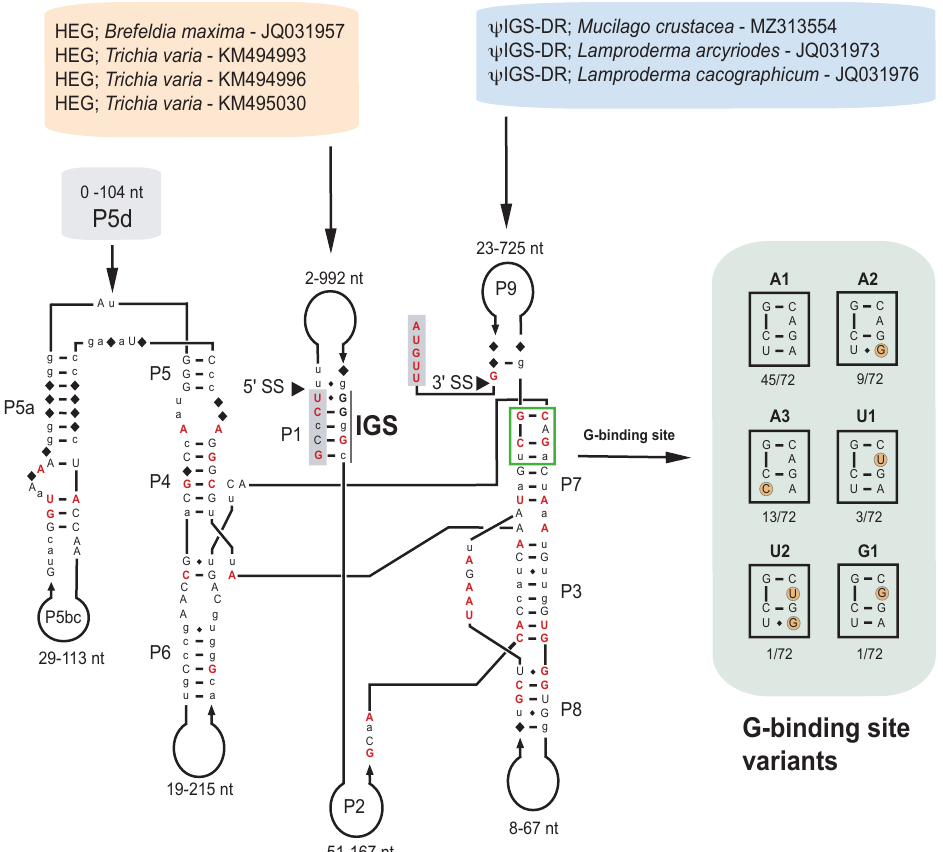
Figure 3. Consensus secondary structure diagram of S1389 group I intron in myxomycetes. The consensus structure is based on 166 nucleotide positions in the catalytic core common among introns from 72 taxa (see Supplementary Table S1). Extensive sequence size variations are noted in most peripheral regions, including the taxa-specific P5d extension. While all homing endonuclease genes (HEGs) are found as P1 extensions, all direct repeat (DR) extensions are located in P9. The latter contains multiple pseudo internal guide sequence ( Ψ IGS) features. Guanosine binding structure variants in P7 are indicated (boxed at right; G-site). P1-P10, paired RNA segments; 5’ SS and 3’SS, exon–intron splice sites. Invariant nucleotide positions among the 72 introns are shown as red uppercase letters. Black uppercase letter, >90% conservation; lowercase letters, ≥ 50% conservation; filled circles, <50%